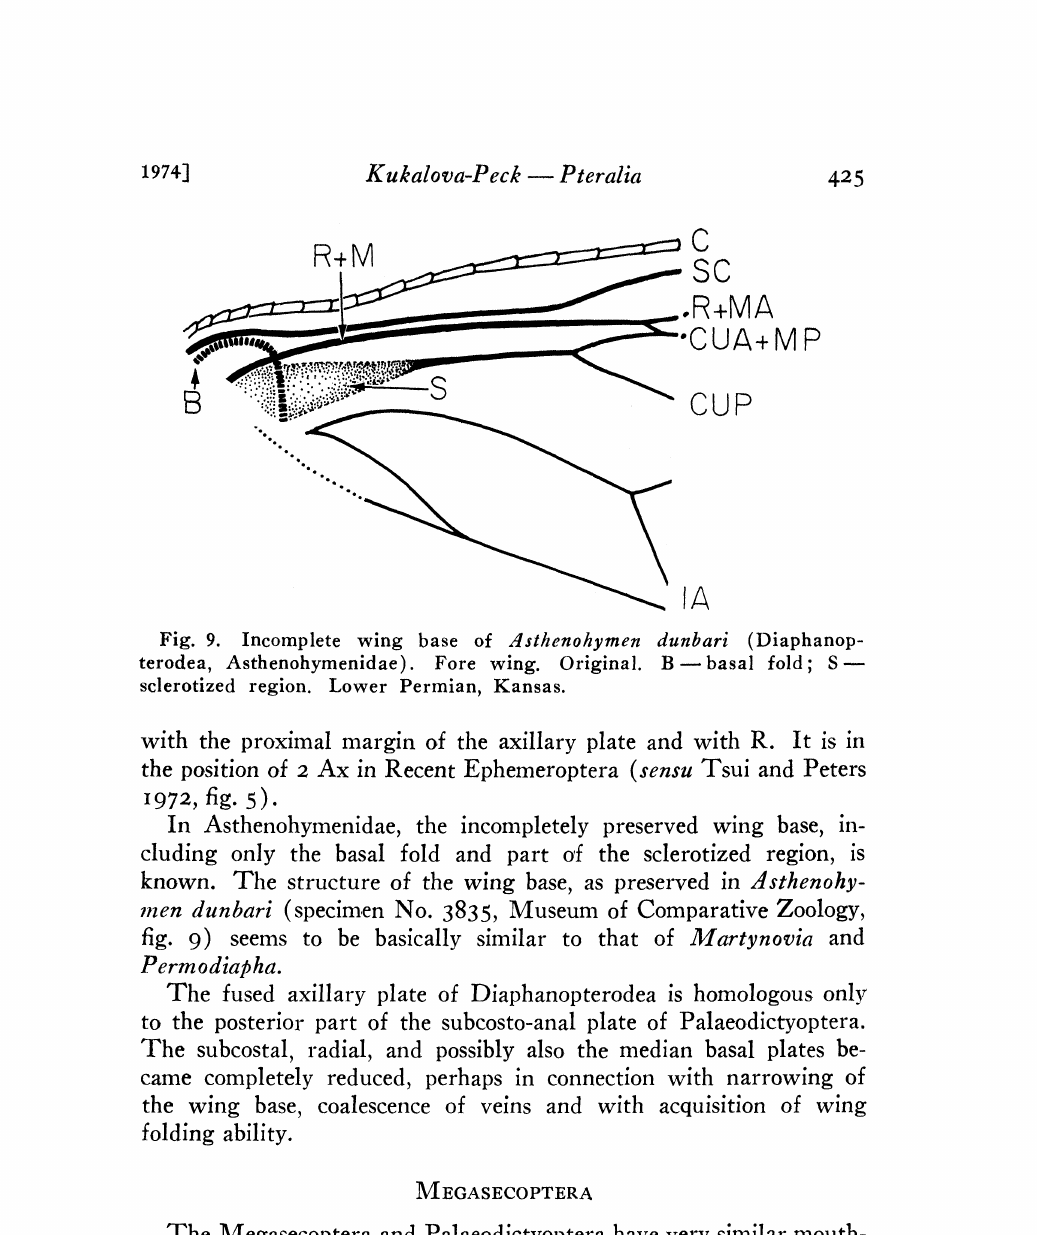
Fig. 9. Incomplete wing base of lsthenohymen dunbari (Diaphanop- terodea, Asthenohymenidae). Fore wing. Original. B--- basal fold sclerotized region. Lower Permian,